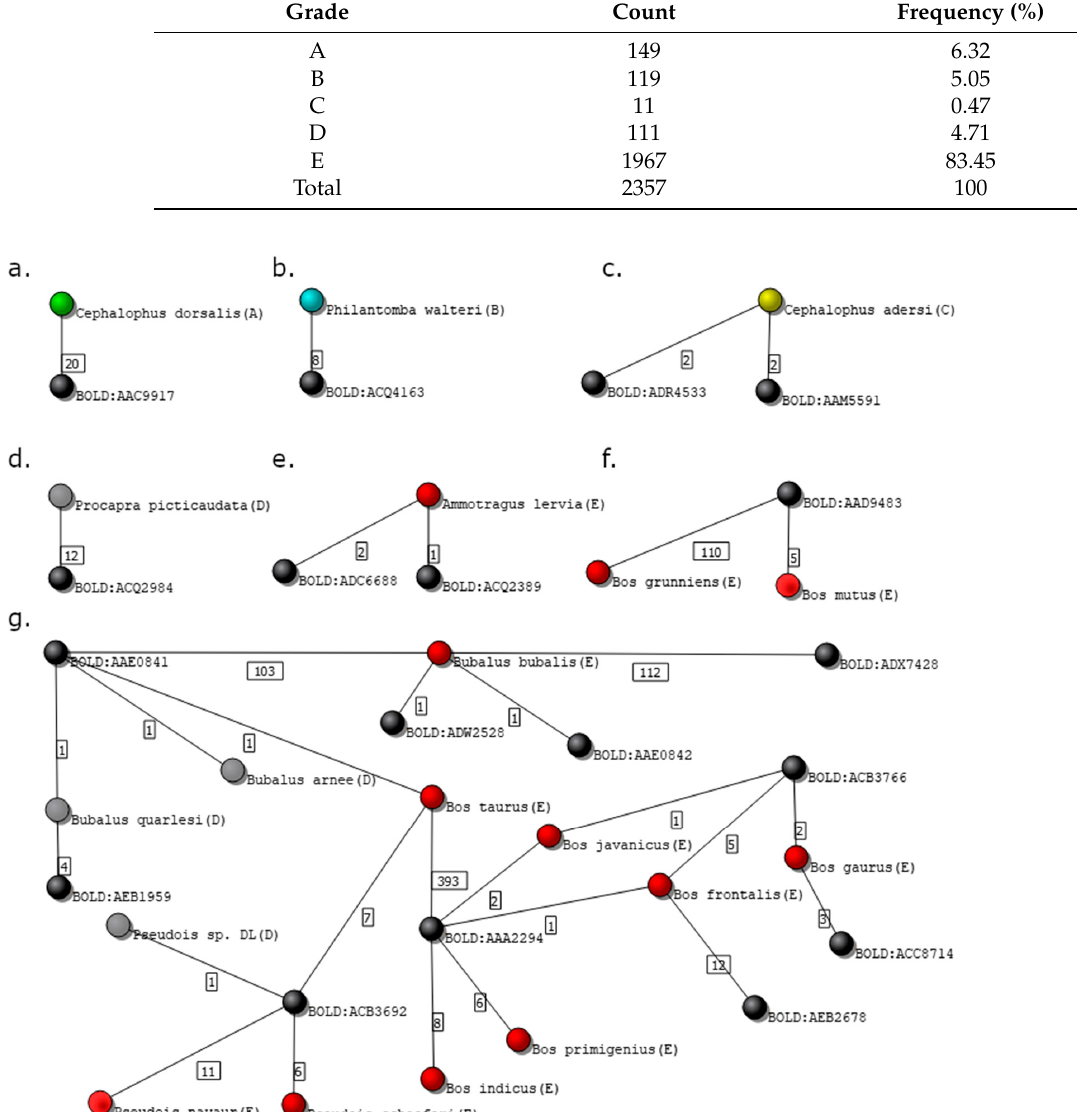
Figure 7. Isolated subgraphs from the Bovidae family dataset. Black nodes represent genetic clusters, while nodes colored in green, blue, yellow, gray, and red represent species graded as A, B, C, D, and E, respectively. ( a ) Species graded with A; ( b ) species graded with B; ( c ) species graded with C; ( d ) species graded with D; ( e , f ) species graded with E; and ( g ) complex isolated subgraph representing several species graded with D and E.